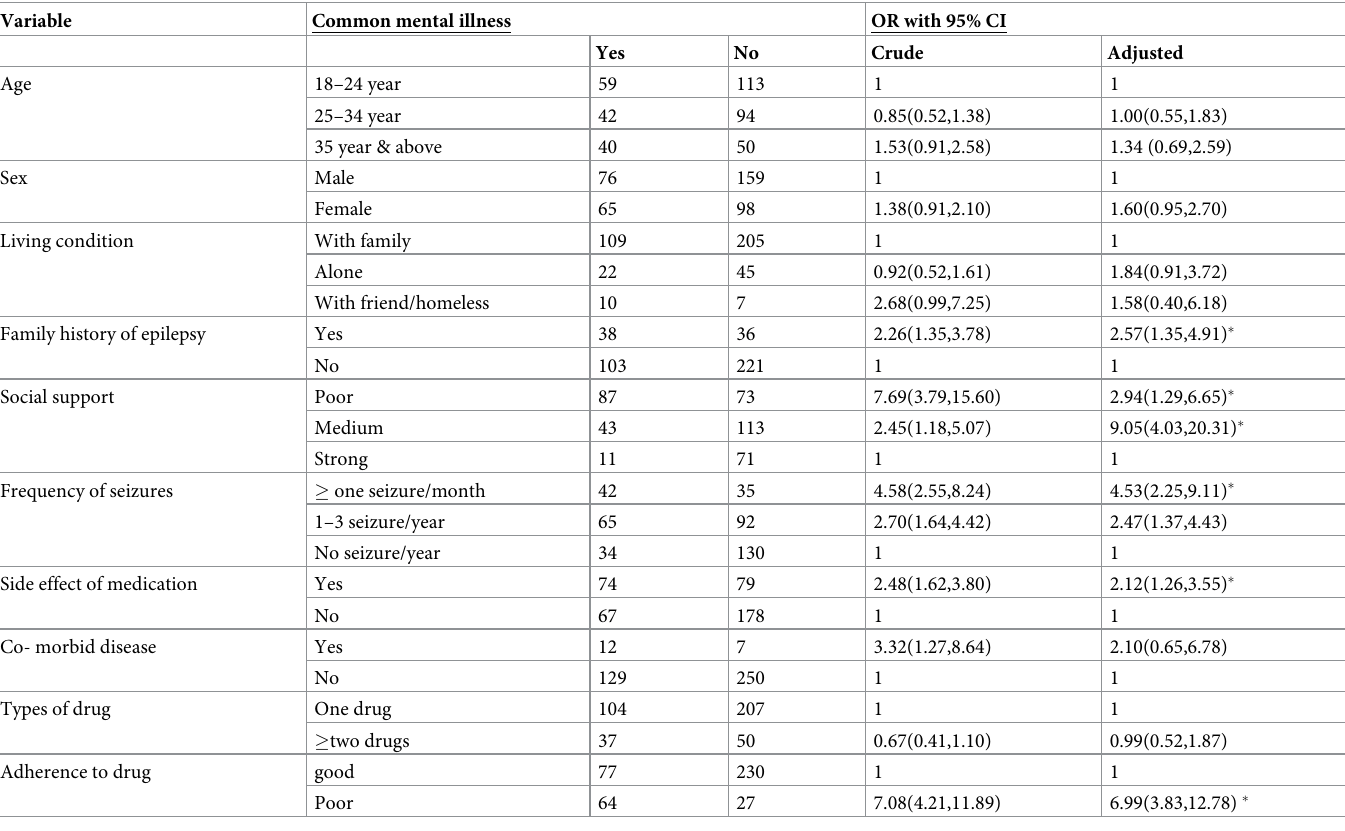
Table 4. Bivariate and multiple analysis of variables associated with common mental illness among people living with epilepsy at government health institutions in Bahir Dar City, 2017(n = 398).